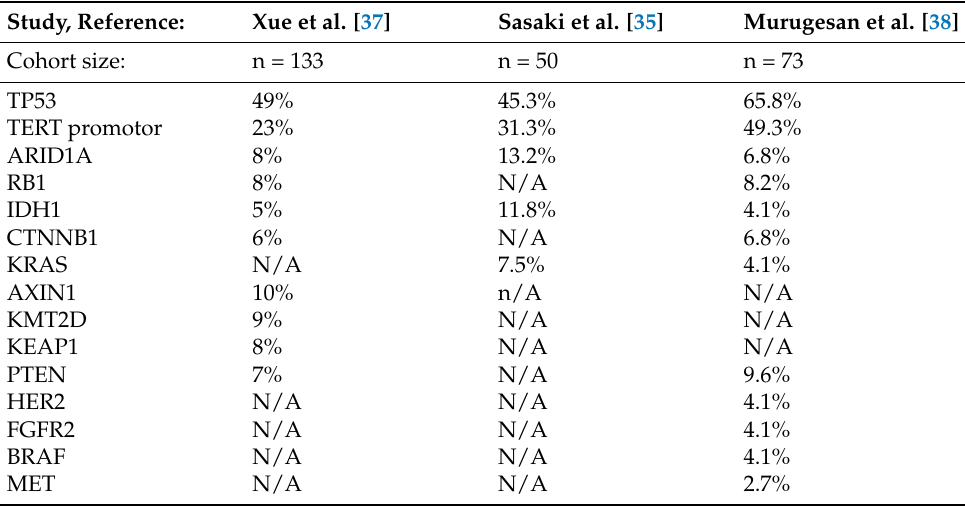
Table 1. Most common genes with alterations found in whole-genome/exome sequencing of com- bined hepatocellular